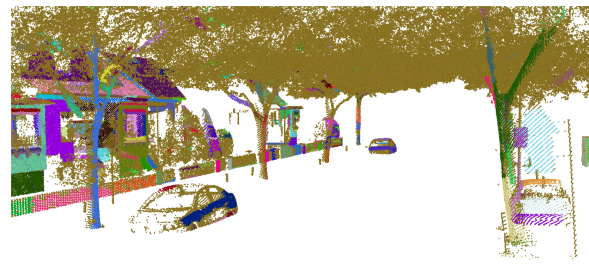
Figure 3. Example homogeneous